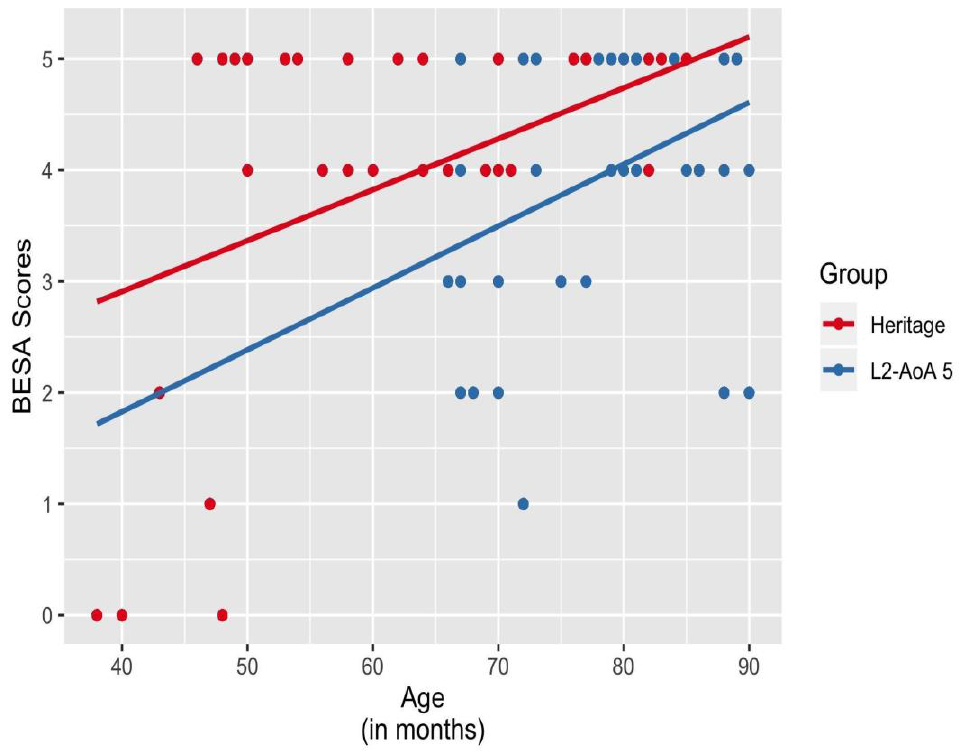
Figure 1. BESA scores as a function of group and